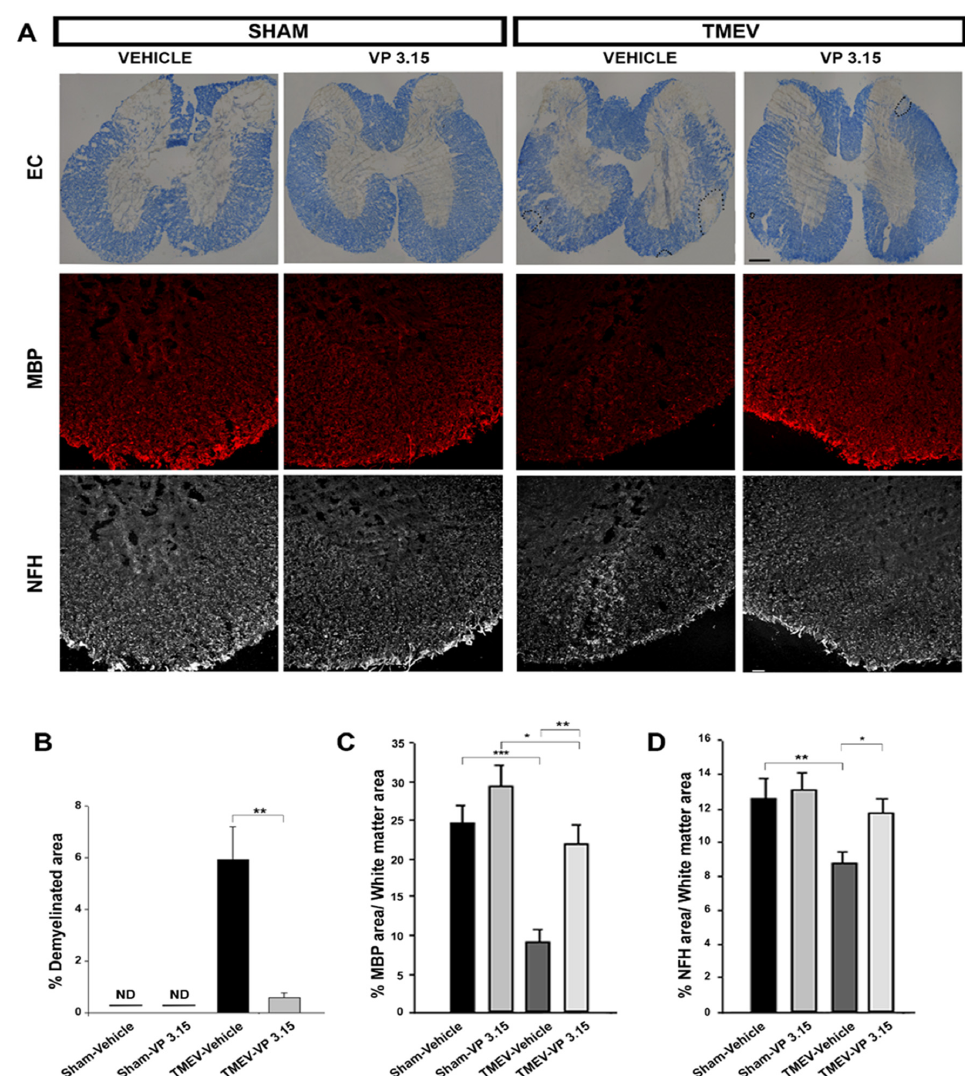
Figure 3. The spinal cord of VP3.15-treated mice presented a lower level of demyelination and axonal damage. ( A ): Detailed views of the spinal cords of vehicle and VP3.15-treated mice stained with eriochrome cyanine and labeled for MBP (red) and NFH (grey). ( B ): Graph showing a decreased percentage of demyelinated area with respect to the white area in the VP3.15-treated mice. The dashed line delimits the demyelinated area. ( C , D ): Histograms of the quantification showing a significant increase in the percentage of both MBP + and NFH + area in the VP3.15-treated compared to the vehicle- treated mice. Scale bar represents 200 µ m (EC) and 50 µ m. Abbreviations: EC = eriochrome cyanine; MBP = myelin basic protein; NFH = neurofilament heavy; ND = non-detected. The statistical analysis was performed using the Student’s t test, with the following values: * p < 0.05; ** p < 0.01; *** p <